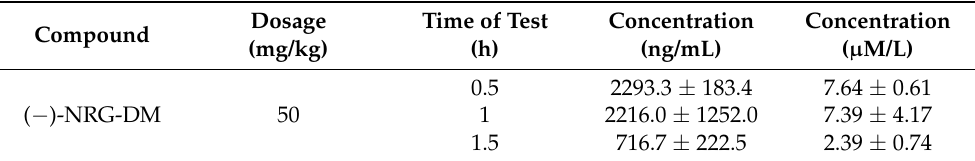
Table 2. Mean plasma concentration of ( − )-NRG-DM administrated via intraperitoneal route in ICR